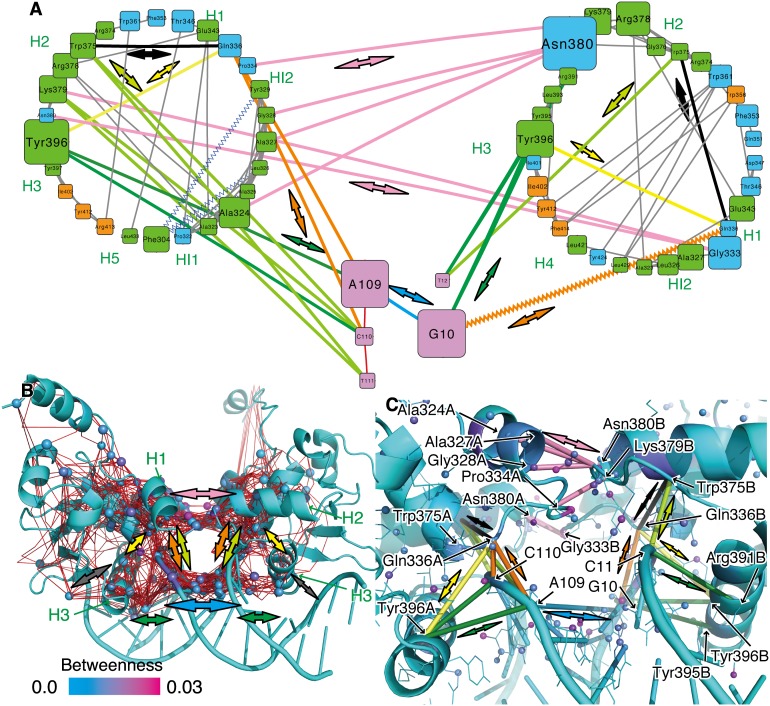
A correlation network in (Ets1)2–DNA model.(A) A simplified correlation network diagram in two-dimension (2D) as a sub-network of the original one shown in Fig. S7. Each node indicates a residue and each edge indicates a proximal residue pair with a highly positive correlation (the maximum value of mDCC ≥0.5 and the distance between the center positions of the modes <5.0 Å). The two circles correspond to the two Ets1 proteins (chain A and chain B correspond to the left circle and right circles, respectively), and the pink nodes are the DNA. The colors of the Ets1 nodes represent secondary structures: green, orange, and cyan indicate α-helix, β-strand, and others, respectively. The sizes of nodes denote the Betweenness values of residues. Important interactions mentioned in the manuscripts are shown as colored edges with bold arrows. (B) A 3D representation of the core network. The colors of atoms and ribbons represent their Betweenness values, and the atoms in the top 5% Betweenness are shown as spheres. Red lines indicate the shortest paths among all of the spheres. (C) The 3D structure around the recognition (H3) helix and the intermolecular interfaces. The pairs of residues corresponding to colored edges in Fig. 3A are shown as cylinders.